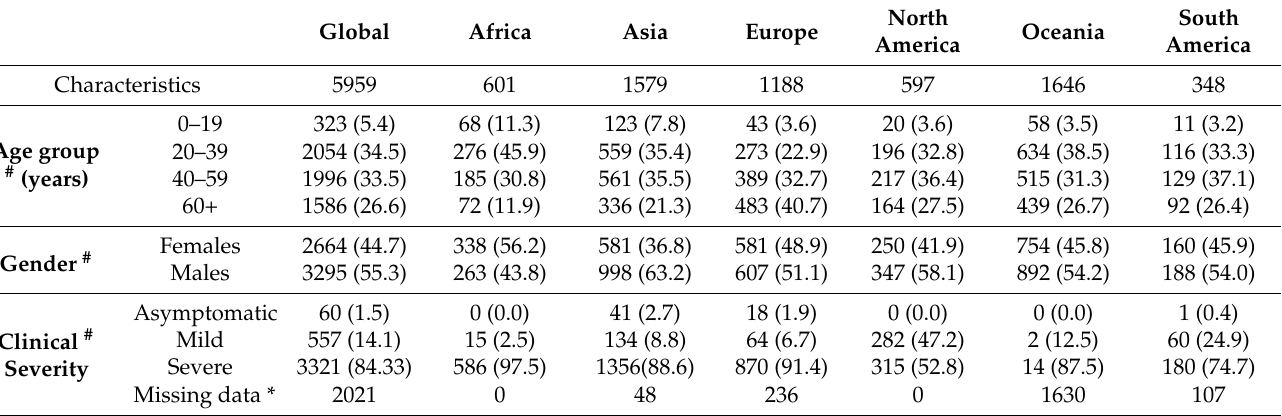
Table 1. Demographics of the 2020 study